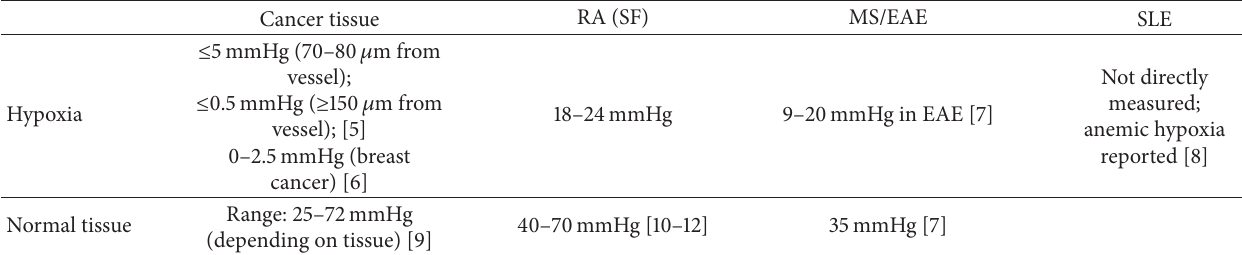
Table 1: Hypoxia in the